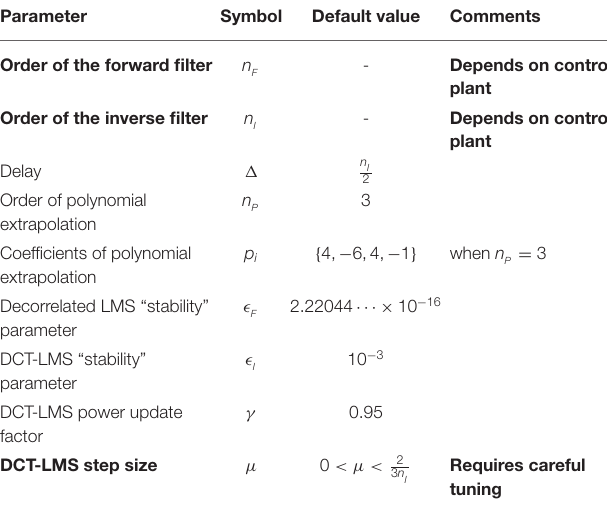
TABLE 1 | Method’s